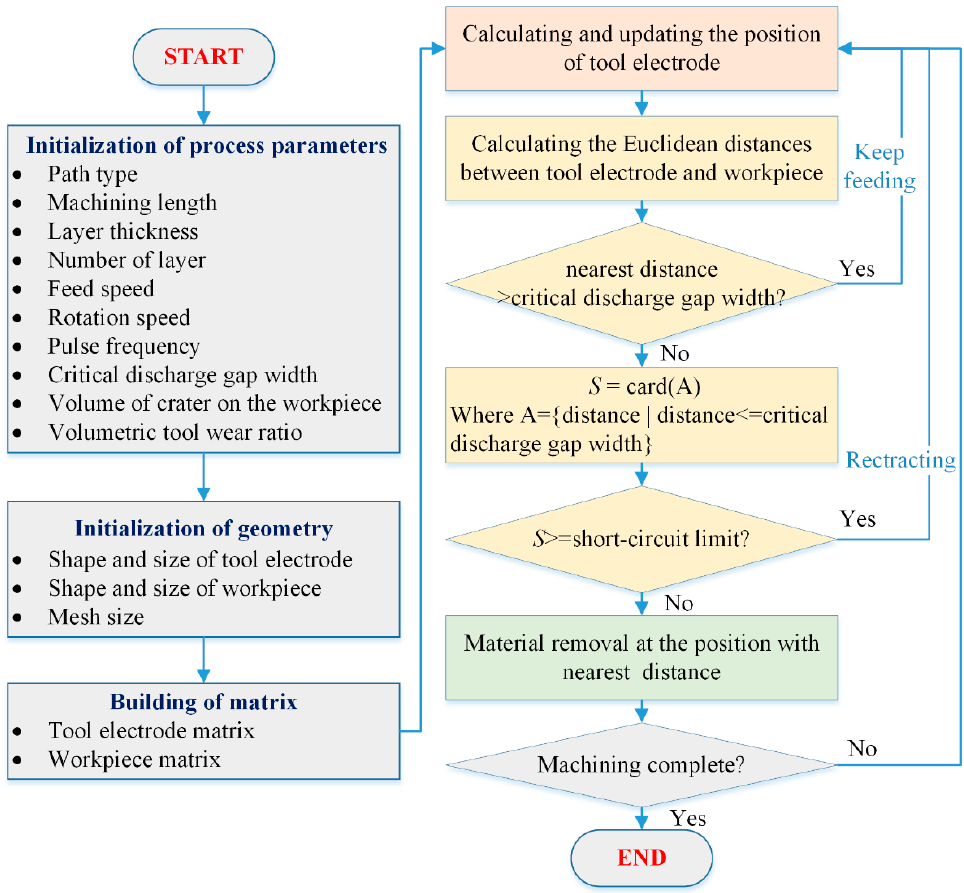
Figure 8. Schematic flowchart of the micro-EDM milling process simulation model.